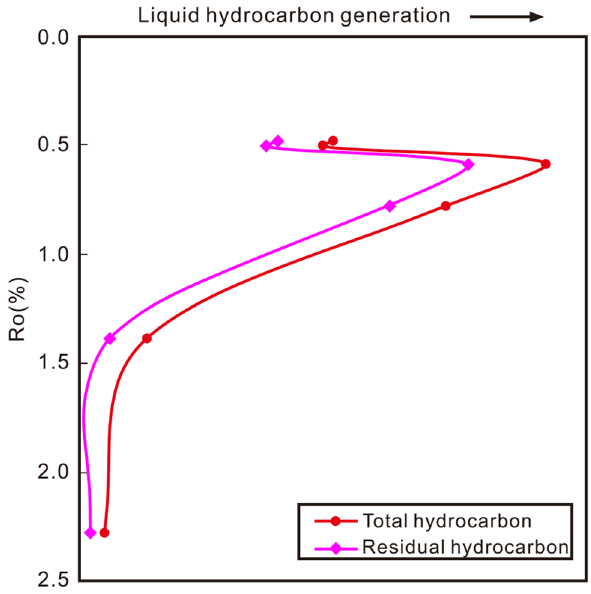
Fig. 5 Hydrocarbon-generation mode of the Paleogene–Neogene source rocks in the Western Qaidam